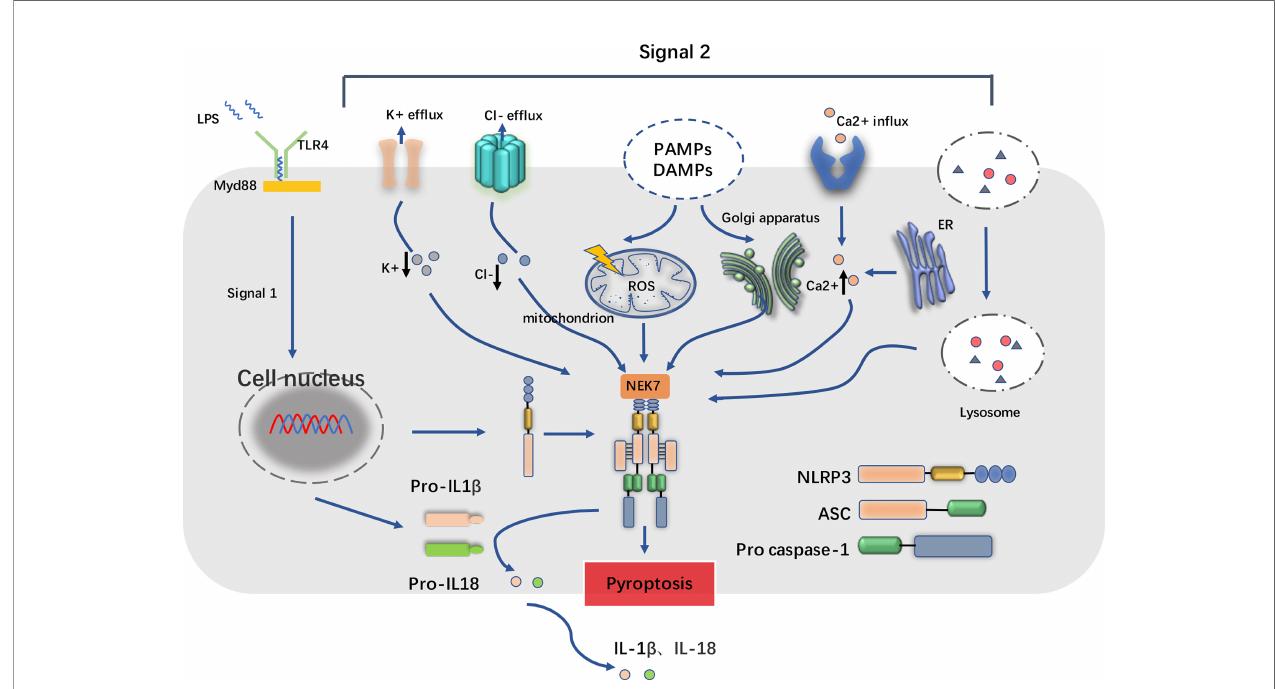
FIGURE 1 | Basic structure of NLRP3 in fl ammasome and its two-step process of priming and activation. The NOD-like receptor family pyrin domain containing 3 (NLRP3) in fl ammasome complex consists of NLRP3 monomers, apoptosis-associated speck-like protein containing a CARD (ASC) and the pro casepase-1. When in fl ammatory stimuli such as lipopolysaccharide (LPS) sensed by Toll-like receptors (TLRs) (e.g., TLR4) and cytokine receptors, the downstream singling adaptors such as MyD88 cooperatively contribute to the priming process, which upregulate the transcription of NLRP3 and IL1 b /IL18, accumulate cytoplasmic pro-IL1 b /pro-IL18. In addition, NEK7, one of the serine/threonine kinases, is also required for the activation of NLRP3 in fl ammasome. In the second step, pathogen-associated molecular patterns (PAMPs) and damage-associated molecular patterns (DAMPs) trigger cellular events including reactive oxygen species (ROS) release, endoplasmic reticulum stress, mitochondrial dysfunction, lysosomal damage, and ionic fl ux such as K+ ef fl ux, Cl- ef fl ux and Ca2+ in fl ux. These facilitate the cleavage of pro casepase-1 into active form casepase-1, and in turn the maturation and release of IL1 b /IL18, consequently leading to the in fl ammatory cell death known as